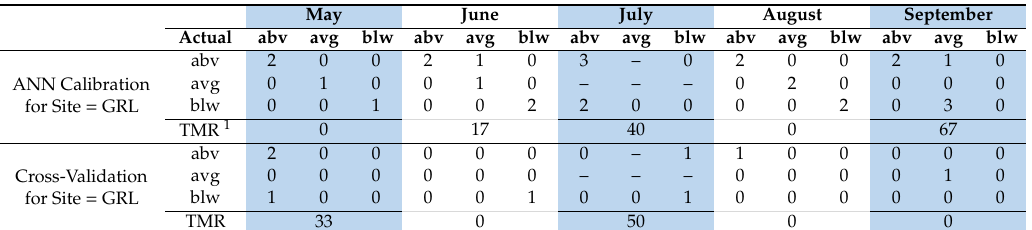
Table 5. Confusion matrices from ANN calibration and cross-validation, showing actual and predicted class membership for the months May through September for the GRL site. AGFM classes are above average (abv), average (avg), and below average (blw) above-ground forage biomass. The total misclassification rate (TMR) for each month is also shown, and is calculated as the number of misclassifications divided by the total number of